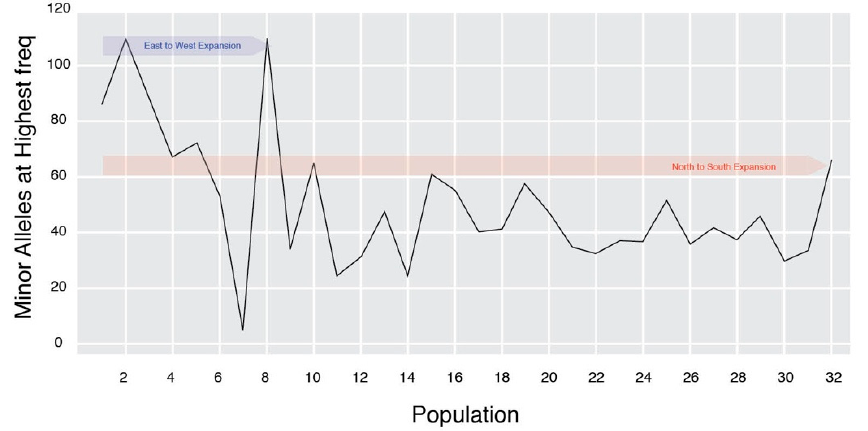
Figure 6. MAHF (minor allele at highest frequency). Populations are numbered from most northern (01—Brunby Plains) to most southern (32—Brogo). Expansion to western extreme (08—Mount Kaputar National Park) is highlighted in blue and to southern extreme (32—Brogo), in red.